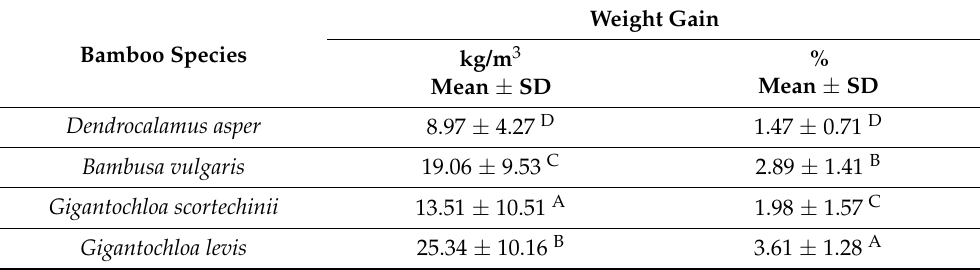
Table 3. Weight percent gain of untreated and treated bamboo strips of four selected species.